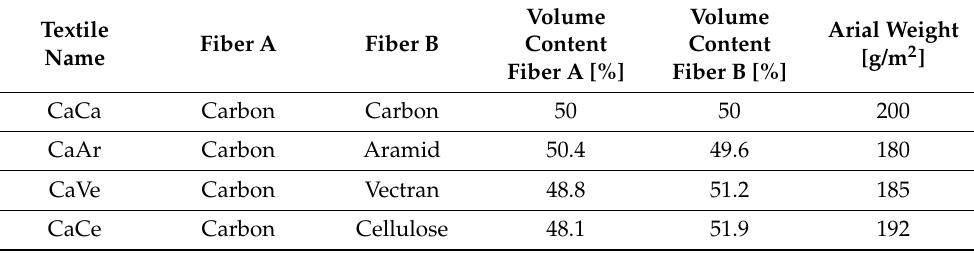
Table 2. Properties of the dry UD-fabrics.